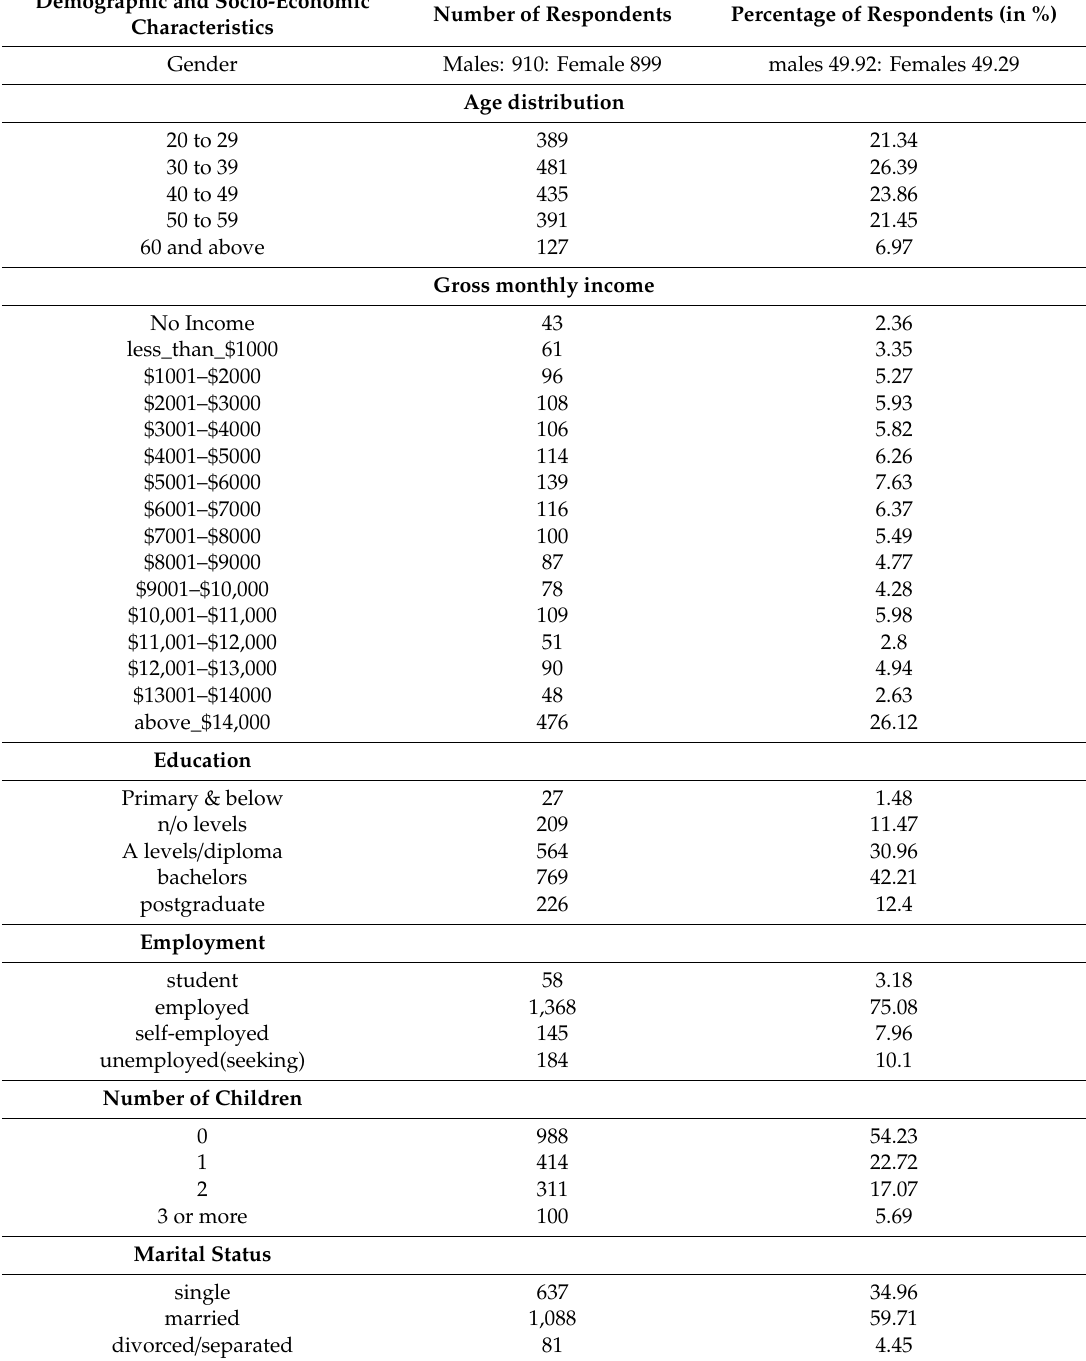
Table 4. Descriptive statistics of sample. Demographic and socioeconomic